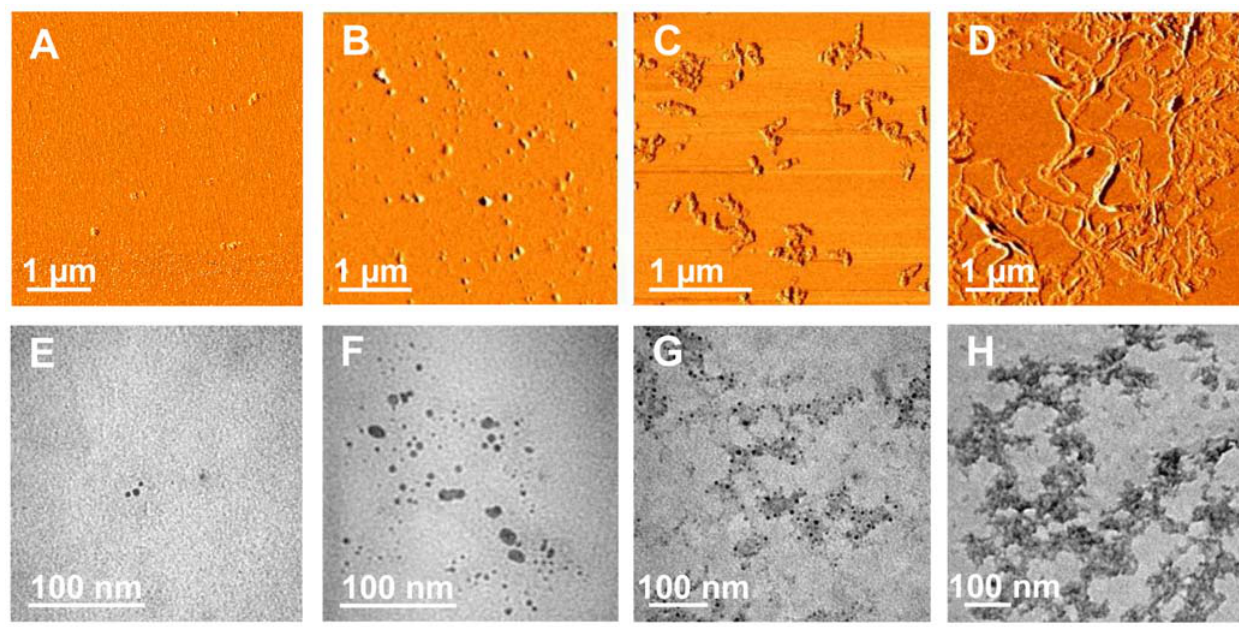
Figure 4. Ub aggregate morphologies for long-term incubations with Cu II and/or TFE. Phase-mode AFM images (A, B, C, D) and TEM micrographs (E, F, G, H) of Ub structures after two months of incubation at 37 u C in the absence of Cu II (A and E); with 3 mol equiv of Cu II (B and F); with 20% TFE (C and G); with 3 mol equiv of Cu II in 20% TFE (D and H).